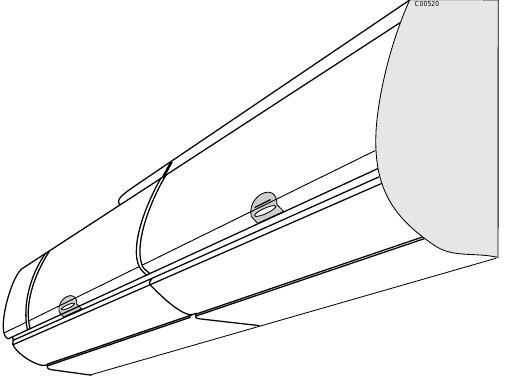
Fig. 1. Schematic of overhead compartment on the Boeing 737 aircraft.